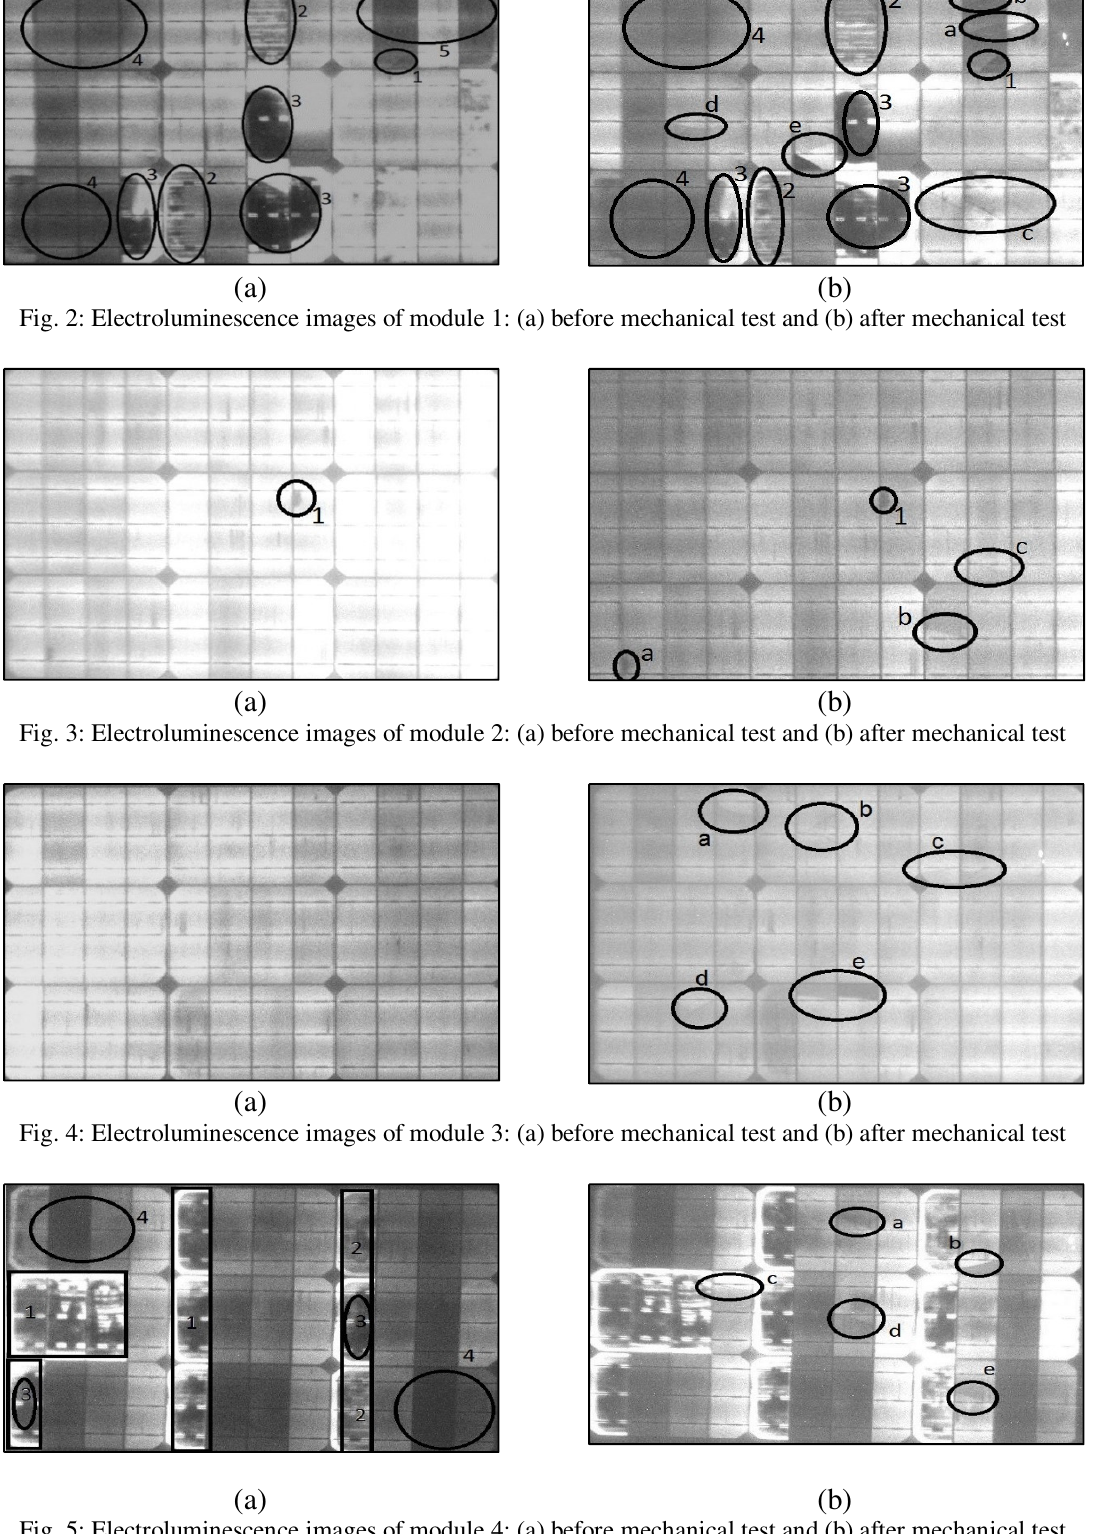
Fig. 5: Electroluminescence images of module 4: (a) before mechanical test and (b) after mechanical